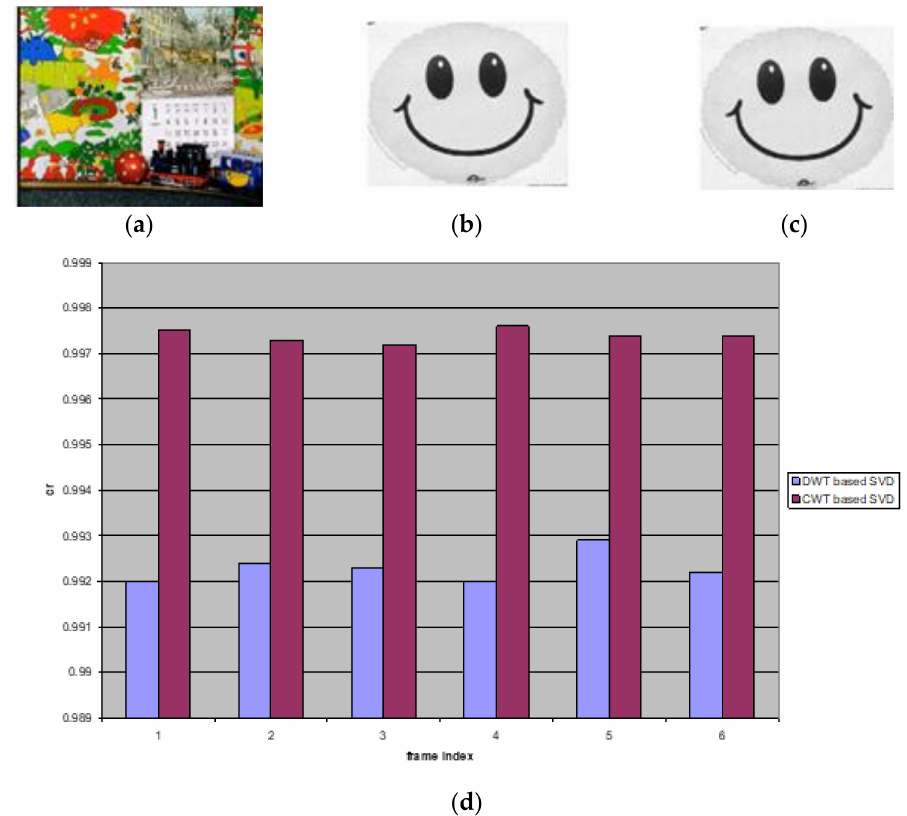
Figure 22. ( a ) The watermarked frame under the histeq attack using the proposed method. ( b ) Extracted watermark from frame 15 in the proposed method ( c ) Extracted watermark from frame 15 of the DWT-based SVD method. ( d ) Correlation values for the extracted watermarks from each frame in the second video scene under the histeq attack.